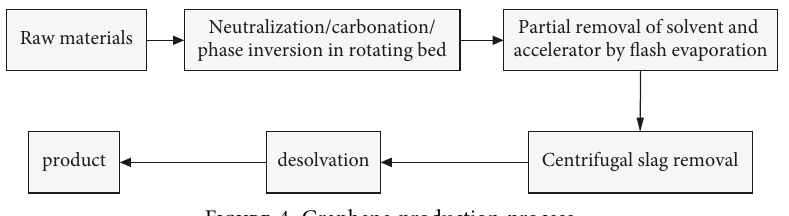
Figure 4: Graphene production process.